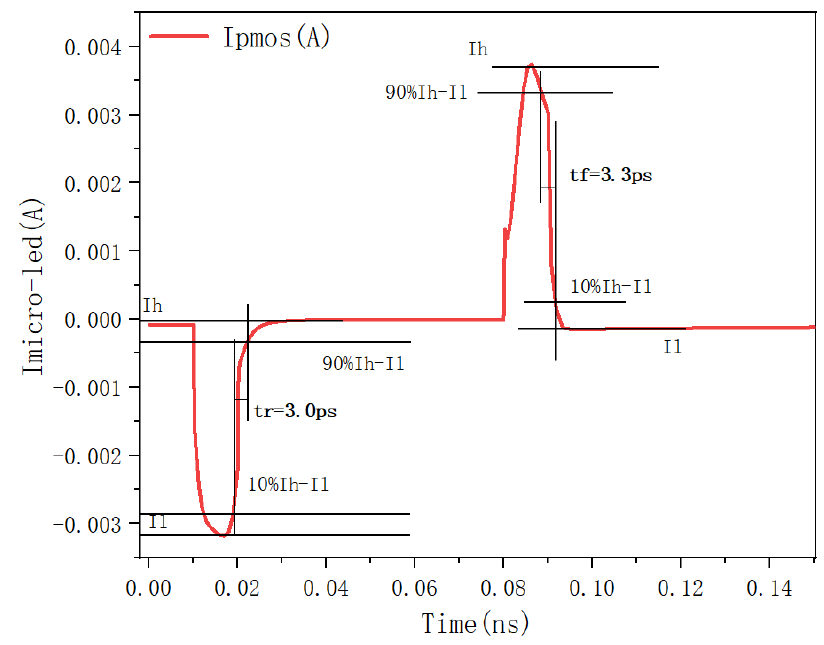
Figure 14. Analysis of rising time and falling time of the output current curve of the PMOS directly driving the micro-LED with time.